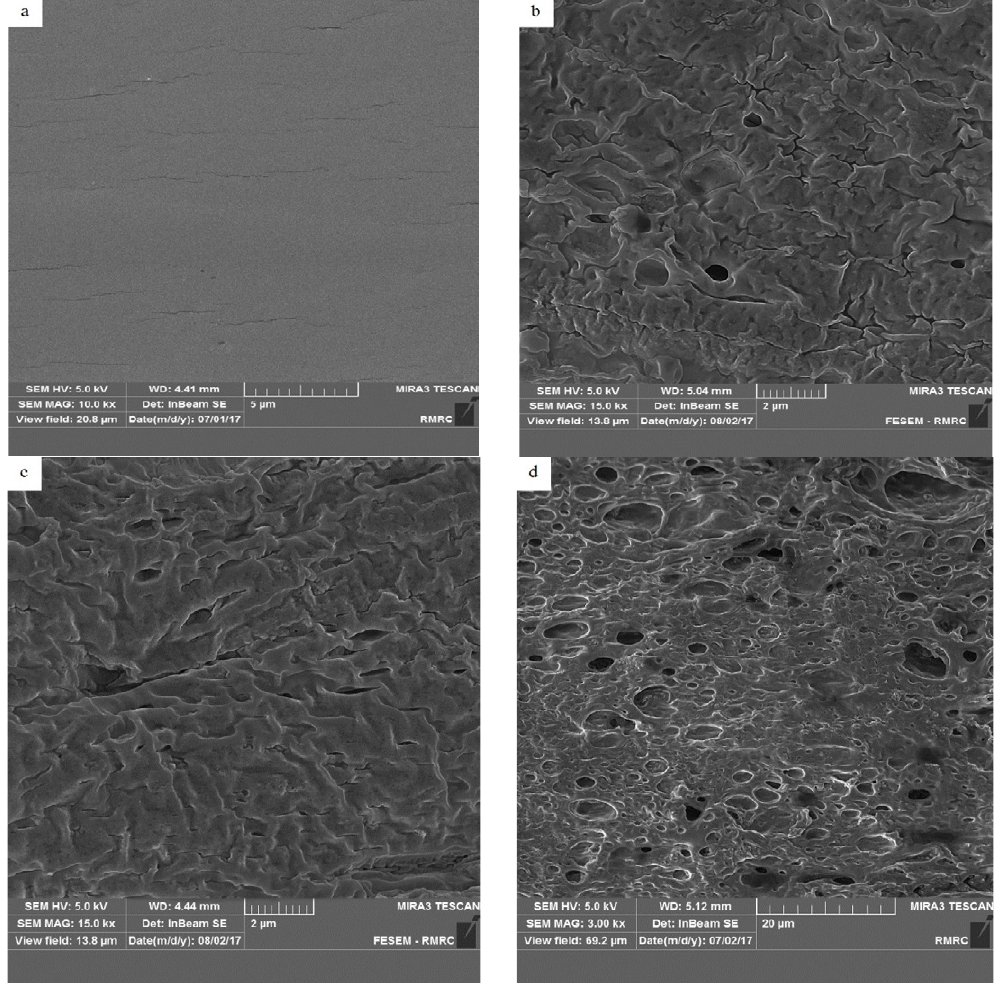
Fig. 3. SEM of chitosan (a), chitosan + pomegranate peel extract (b), chitosan + grape seed extract extract (c) and chitosan + M. spicata essential oil (d) (MSO)